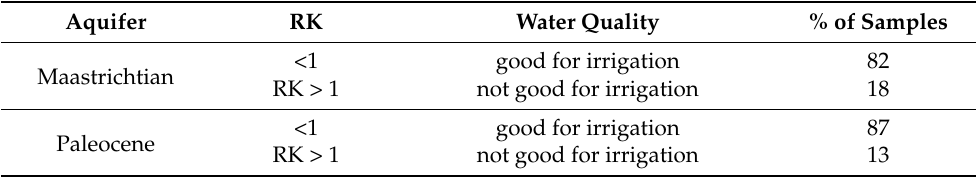
Table 8. Water classification according to the Kelley ratio (KR).